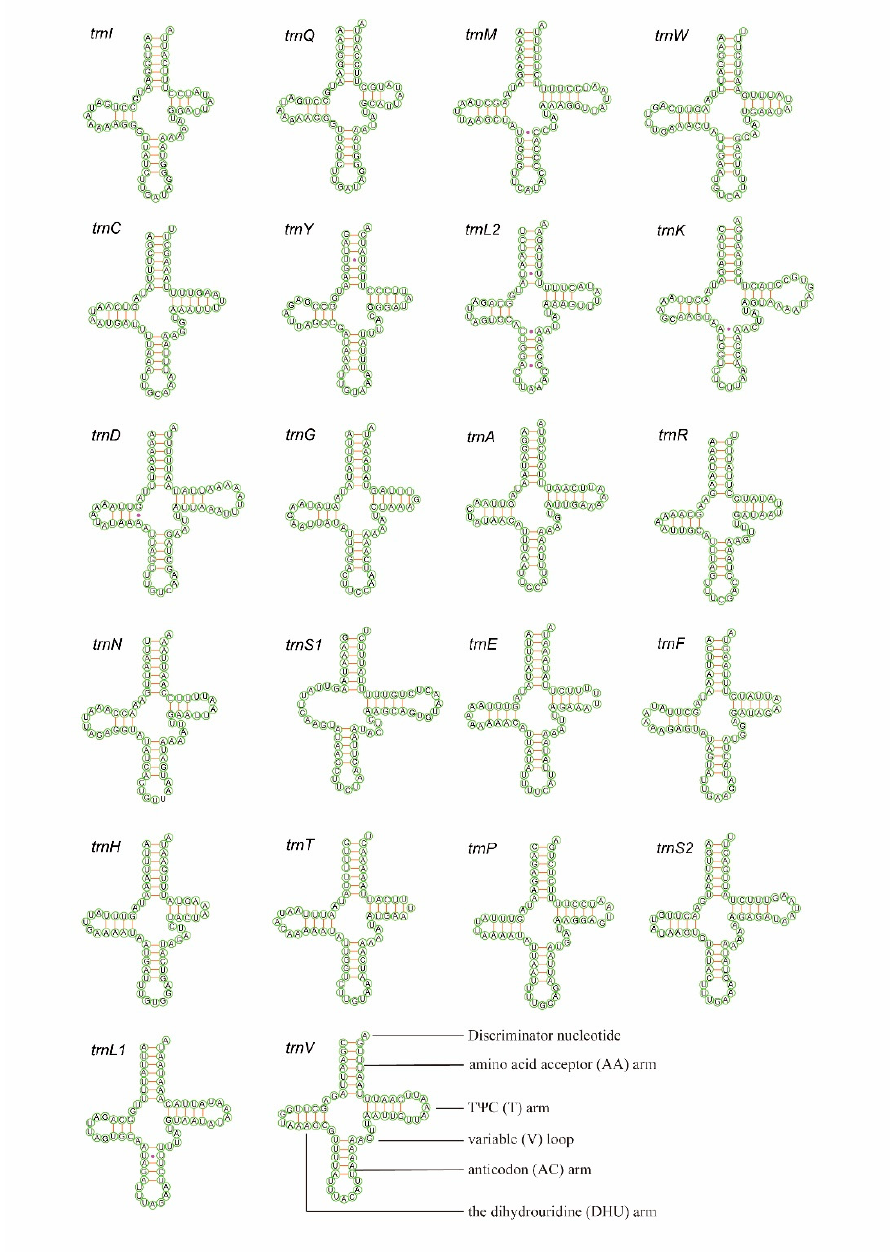
Figure 4. Inferred secondary structure for the tRNAs of X. variegatus